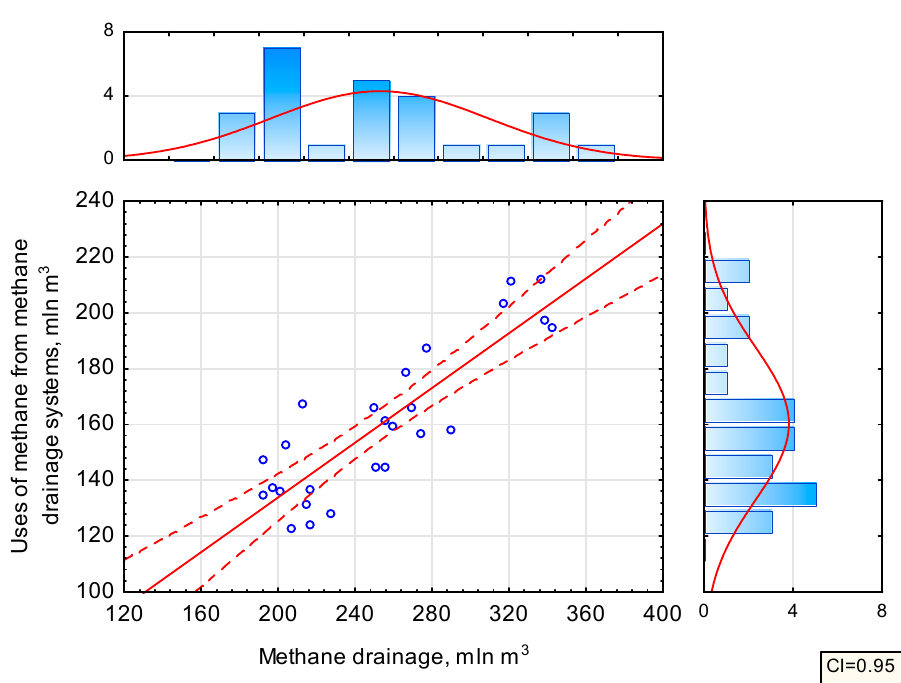
Figure 7. Relationship between methane drainage and uses of methane from methane drainage system in Poland.